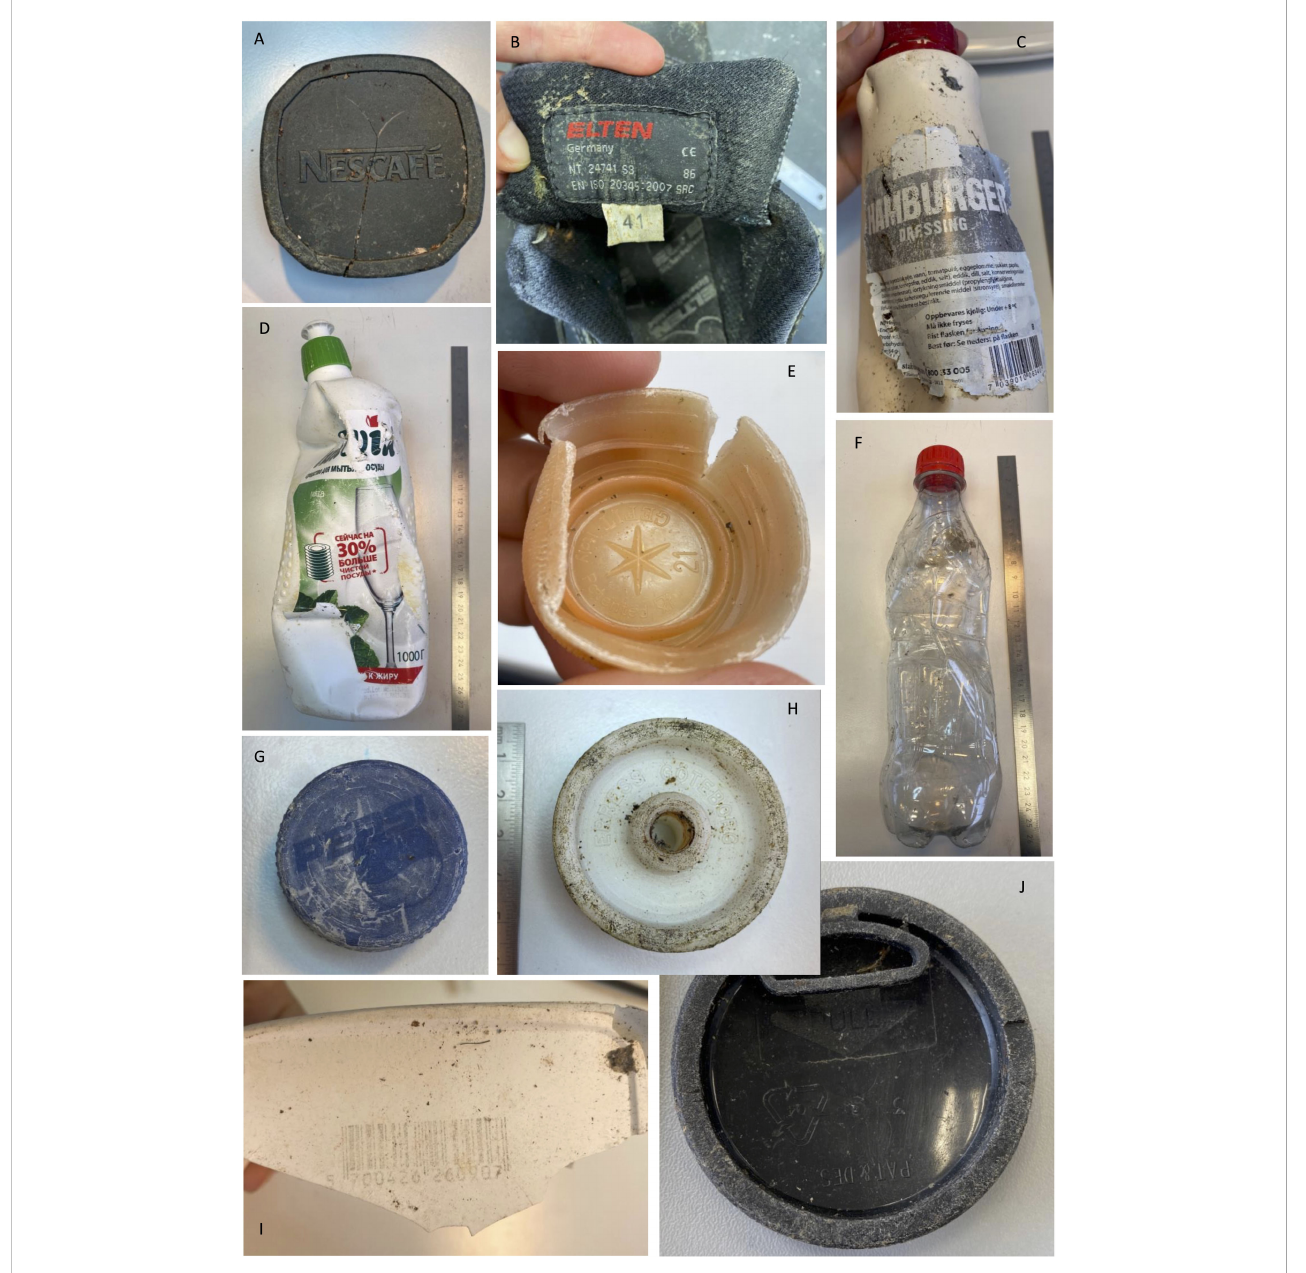
FIGURE 2 Photographs of items for which the provenance was determined, thus (A) Global, (B) Germany, (C) Norway, (D) Russia, (E) Italy, (F) Global, (H) Sweden, (I) Denmark, (J) English